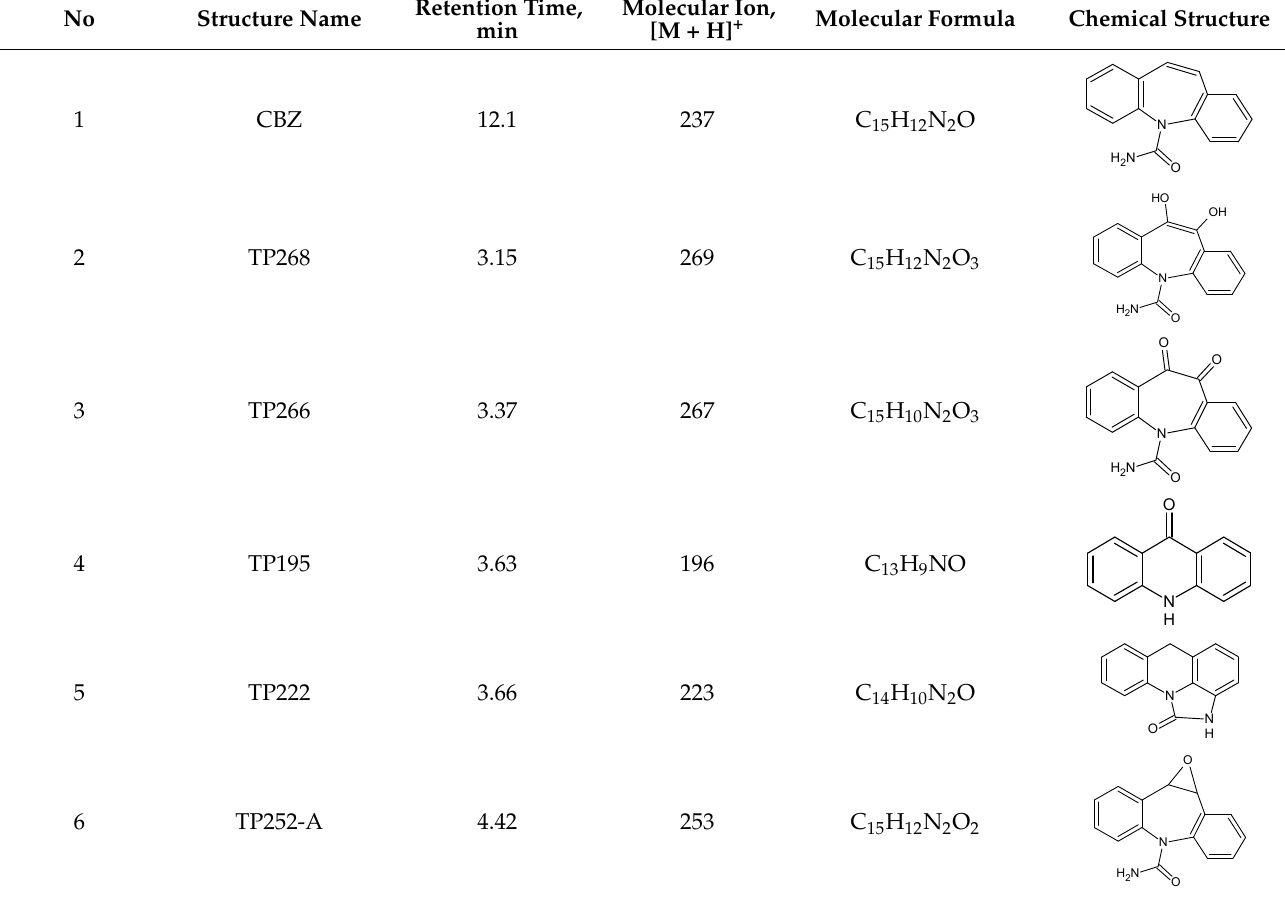
Figure 2. Normalized CBZ concentration vs. irradiation time in the presence and absence of various scavengers. Table 3. Identified CBZ transformation products.